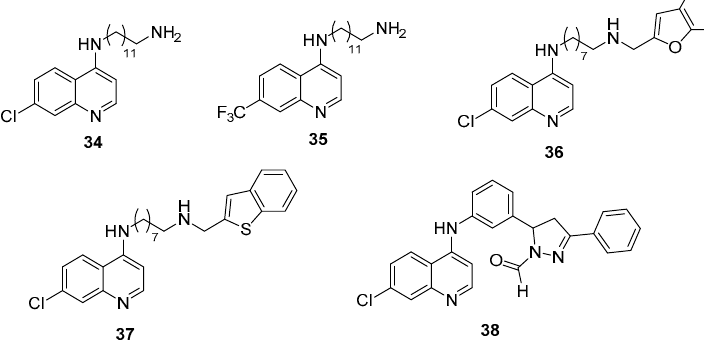
Scheme 9. AQ autoinducer analog QSIs possessing a 4-aminoquinoline core.